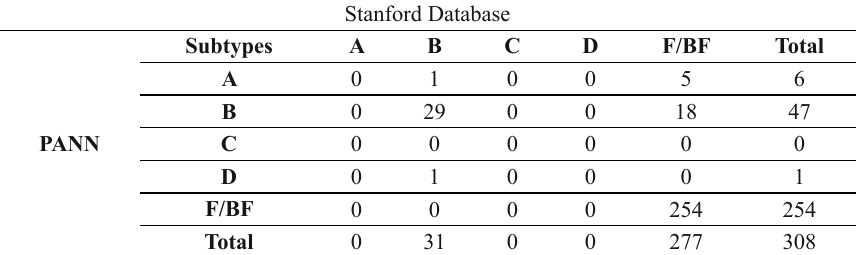
General comparison of subtypes of HIV-1 sequences between Stanford and PANN.